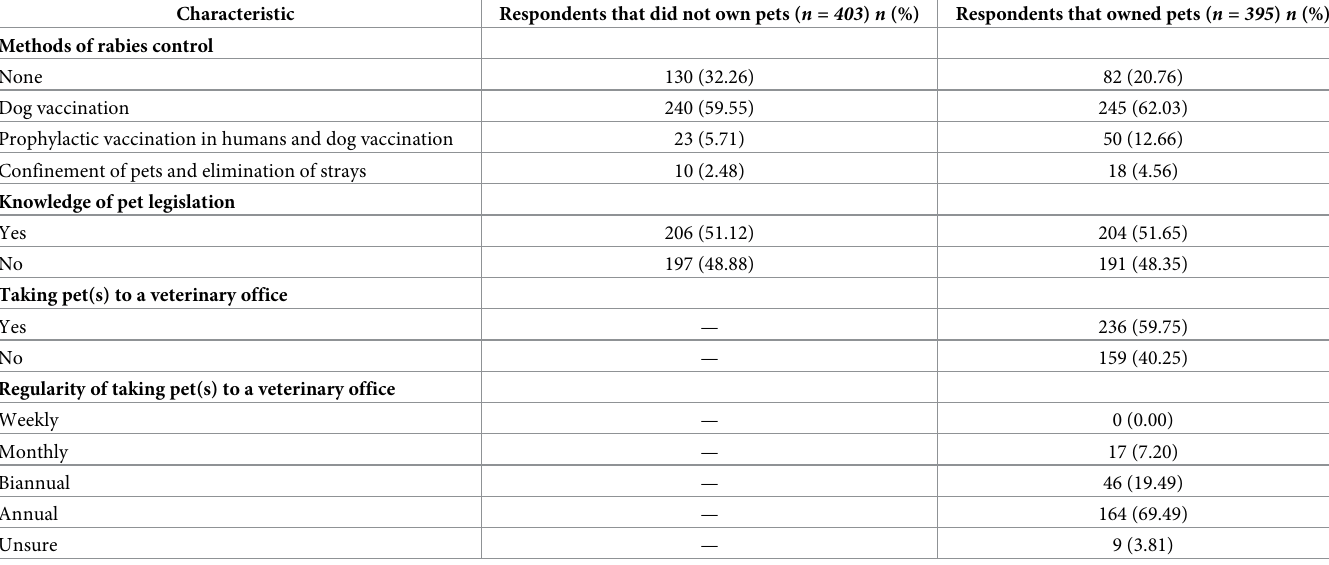
Table 5. Knowledge of rabies prevention amongst respondents that did not own pets and pet